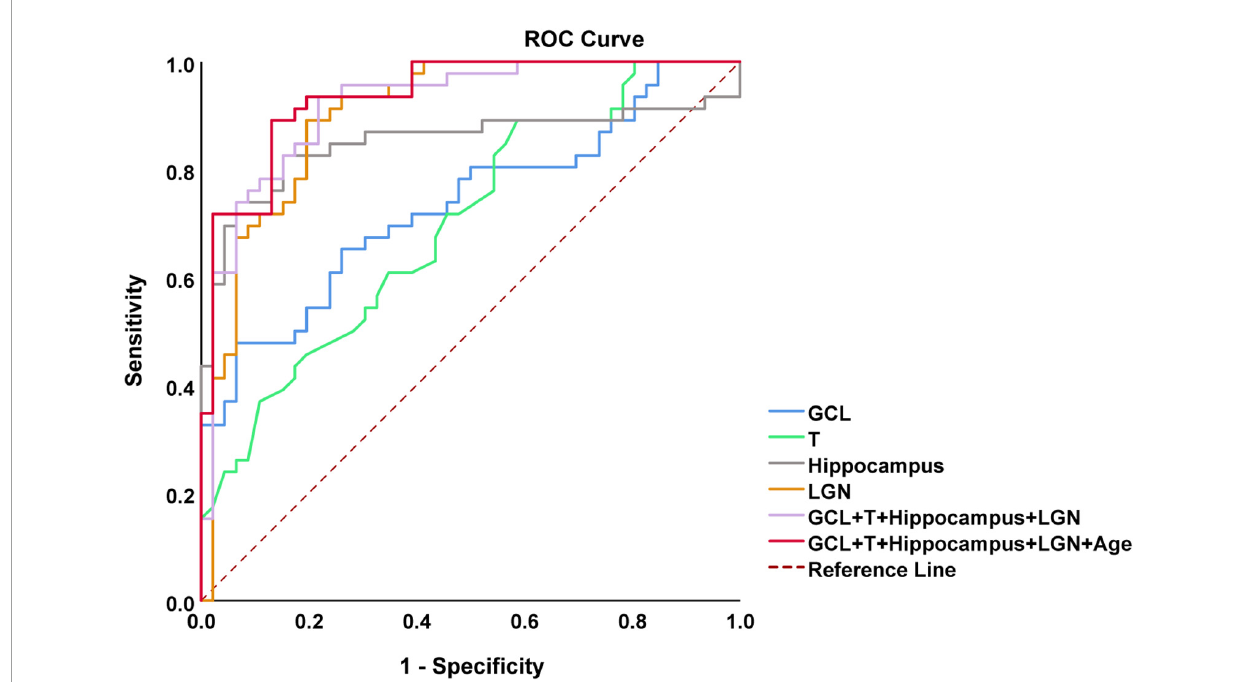
FIGURE6 Receiving operating characteristic (ROC) curves analysis of combined OCT and multimodal MRI for diagnosis of AD. The model combining thickness of GCL and temporal quadrant pRNFL (T), volume of hippocampus and lateral geniculate nucleus (LGN), and age showed the best performance to identify AD patients [area under the curve (AUC) = 0.936, sensitivity = 89.1%, specificity = 87.0%]. AUC, area under the curve; ROC, receiver operating characteristic curve; OCT, optical coherence tomography; GCL, ganglion cell layer; pRNFL, peripapillary retinal nerve fiber